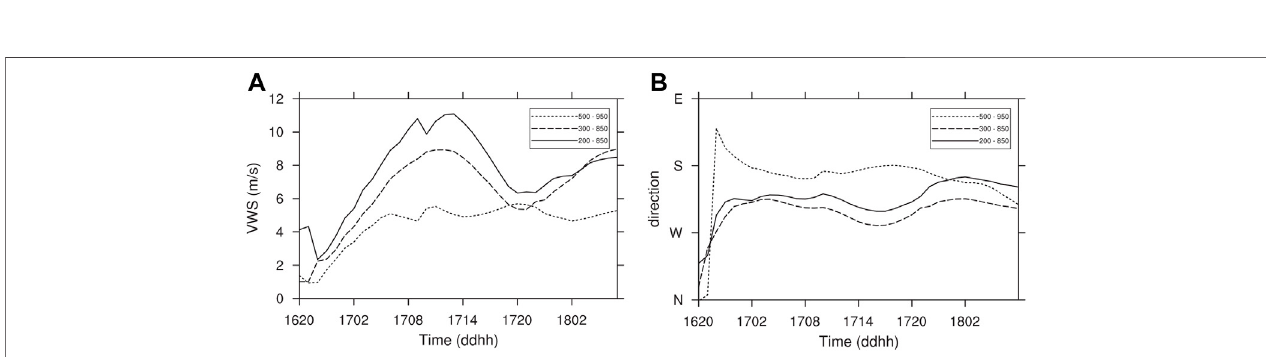
FIGURE5| TimeevolutionofenvironmentalVWSmagnitude (A) anddirection (B) indifferentverticallayersoverRumbia.HeretheVWSisde fi nedasthedifference between the horizontal mean wind vector averaged within a radius of 500 km from the storm center at two given pressure levels.